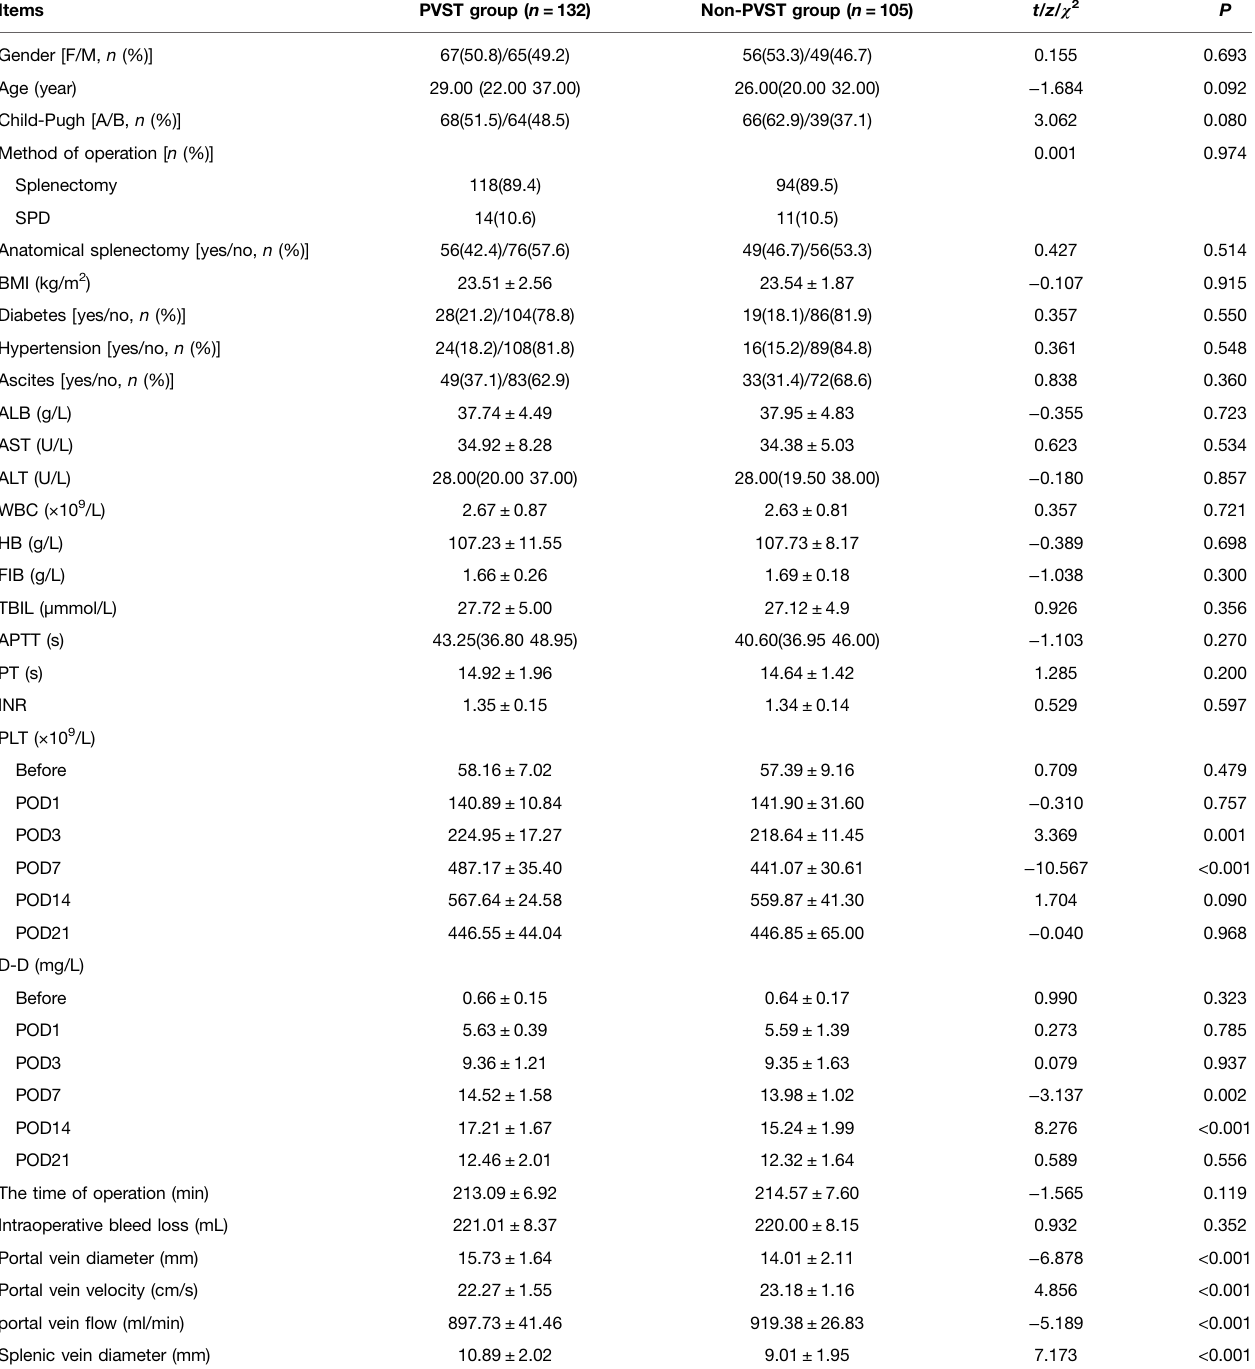
TABLE 3 | Univariate analysis of perioperative clinical data of patients in the PVST group and non-PVST group.